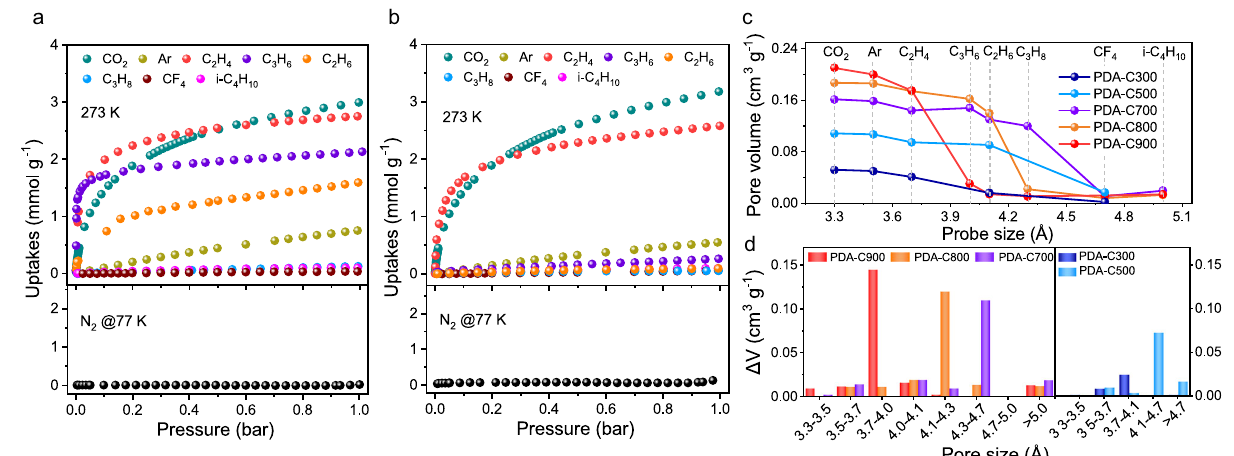
Fig. 3 | Sorption behavior of gas probes and porosity information. Sorption equilibrium isotherms of various gas probes with minimum molecular dimensions ranging from 3.3Å (CO 2 ) to 5.0Å (i-C 4 H 10 ) at 273K and N 2 at 77K on a PDA-C800 and b PDA-C900materials; c TheporevolumesofPDA-Cxcalculatedfromdifferent probe gases based on the Dubinin-Astakhov (D-A) equation (the data points from lefttorightwerecalculatedfromprobinggasesofCO 2 ,Ar,C 2 H 4 ,C 3 H 6 ,C 2 H 6 ,C 3 H 8